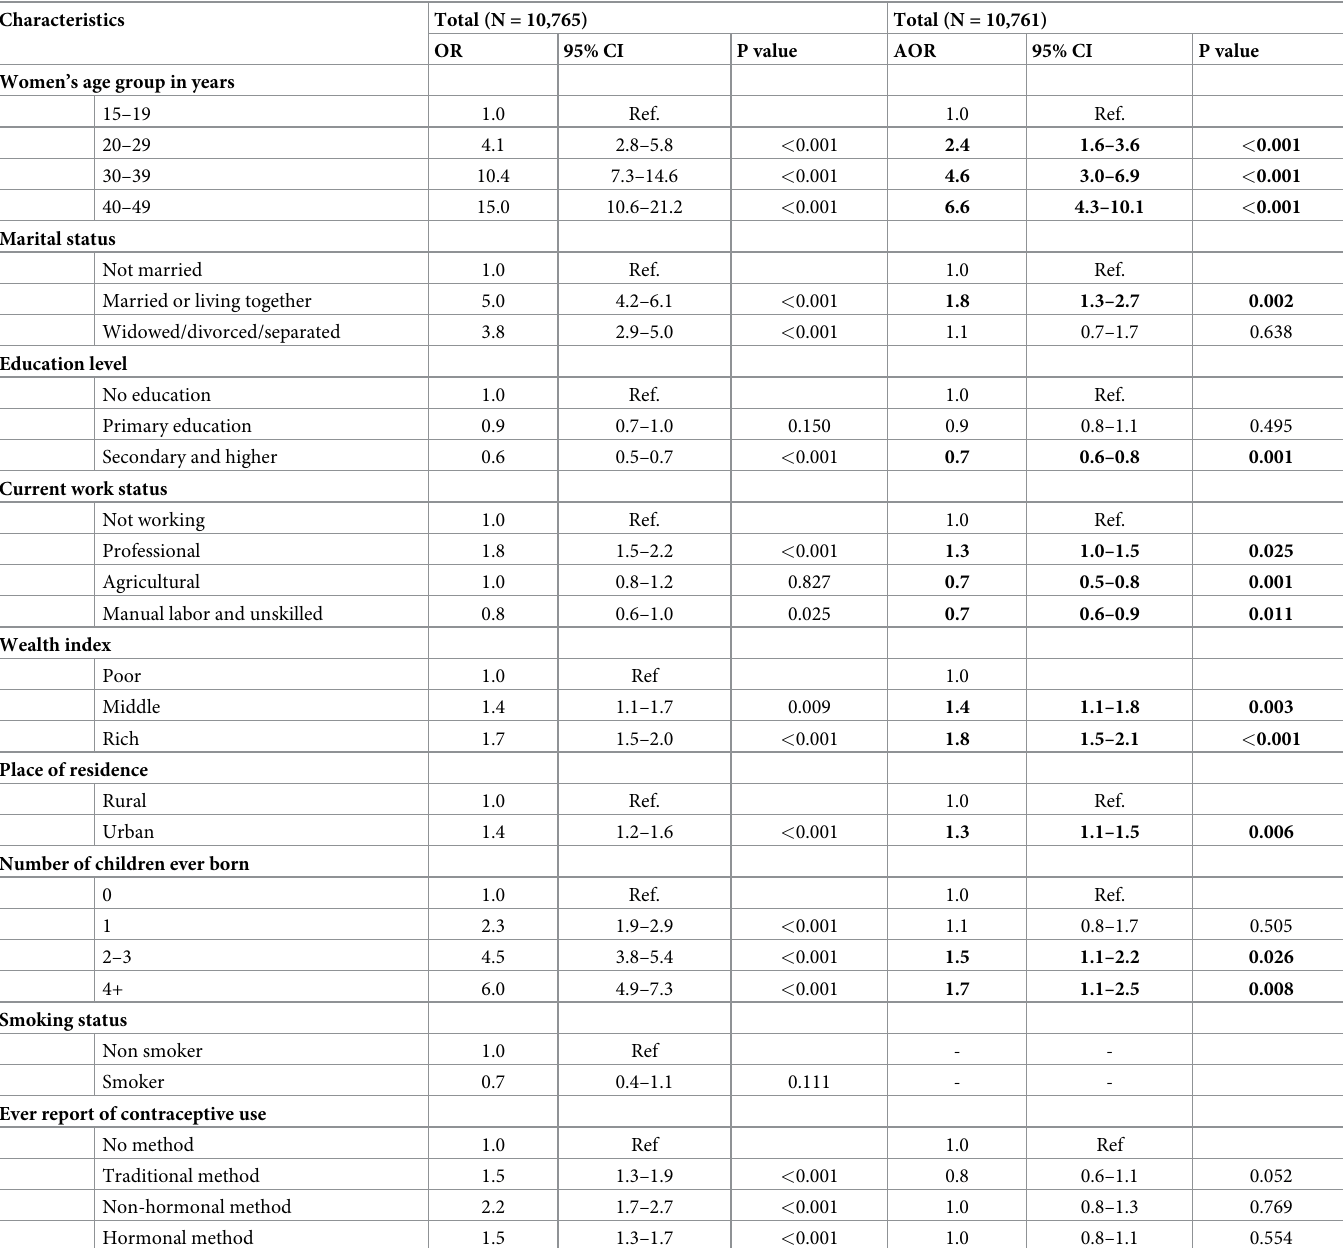
Table 3. Risk factors associated with overweight and obesity in unadjusted and adjusted logistic regression analysis.